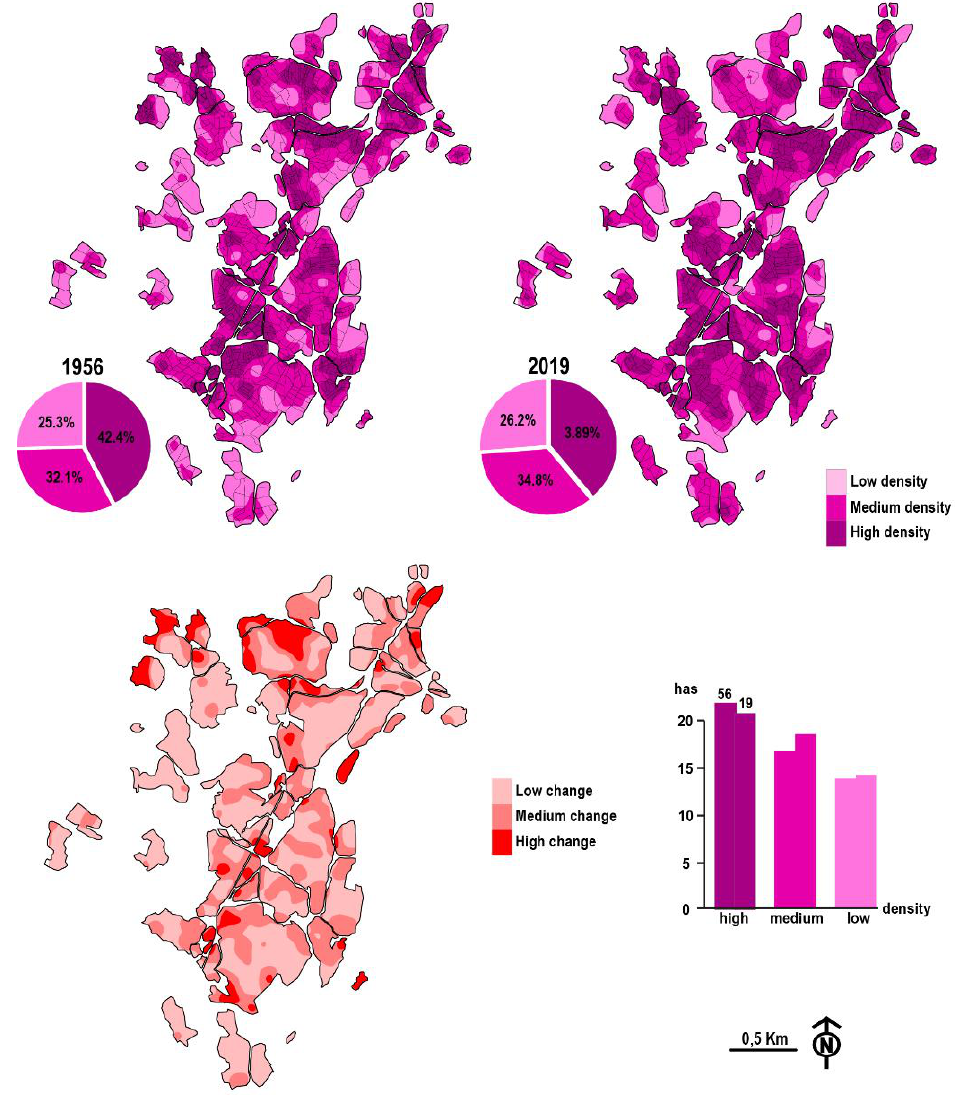
Figure 5. Density and changes in the Bustarviejo land parcels (1956–2019). Own elaboration. From the field transects and the photointerpretation of the two sources of digital The dimensions and size of the enclosed areas in Rascafría (941 ha) were two condi- information used, two types of dynamics were identified that affect the boundaries and tioning factors in the distribution and variety of its land parcels (Figure 6). Three specific perimeters of the parcels of land (Figure 7). On the one hand, some of the parcels had been parcel types could be differentiated: the first were highly fragmented and associated with divided using wood and the network of irrigation ditches on the Lozoya River; the second were associated with diffuse enclosures, established on the lower slopes; and finally, a residual type was located far from the water run-off from the slopes and they were used for dryland farming, which subsequently either underwent conversion into pasture or disappeared. The highest den- sity land parcels reached extensions of 287.3 ha (30.5%) in 1956 and 331 ha (35.1%) in 2019, and they were mostly related to valley bottom mowing pastures or they were associated with the densest stretches of the transversal irrigation network. In this case, the network of land parcels was denser in 2019 relative to 1956 as a consequence of the proximity of the urban area and the processes of land parcel fragmentation. Land parcels with medium density values occupied 388.6 ha (41.2%) and 370.4 ha (39.3%) on dryland farming, grass- lands or areas of difficult access. Lastly, low density land parcels covered 265 ha (28.2%) and 240.3 ha (25.2%), and they were associated with sloping wet pastures and old dryland farming areas that have maintained their physiognomy between the two dates analysed. Overall, rates of change are in the medium range and these occupied a surface of 737.7ha (78.6%), indicative of the relative stability of the land parcels. By comparison, extreme changes occurred over much smaller surfaces. The areas with a change rate in the lowest range occupied a surface of 91 ha (9.6%), with relative intense reparcelling in the areas